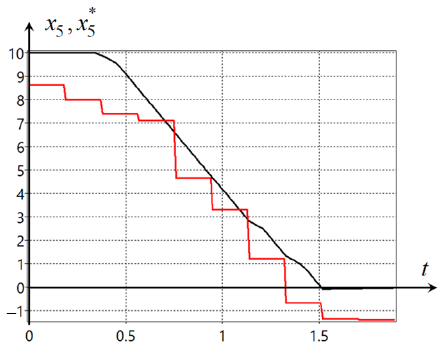
Figure A5. Plots of optimal x 5 and x 5 ∗